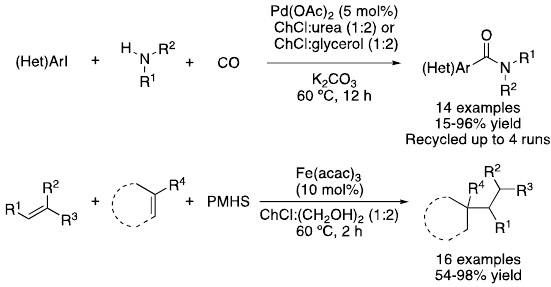
Table 5. Selected examples of MCR catalyzed by transition metals in DESs.